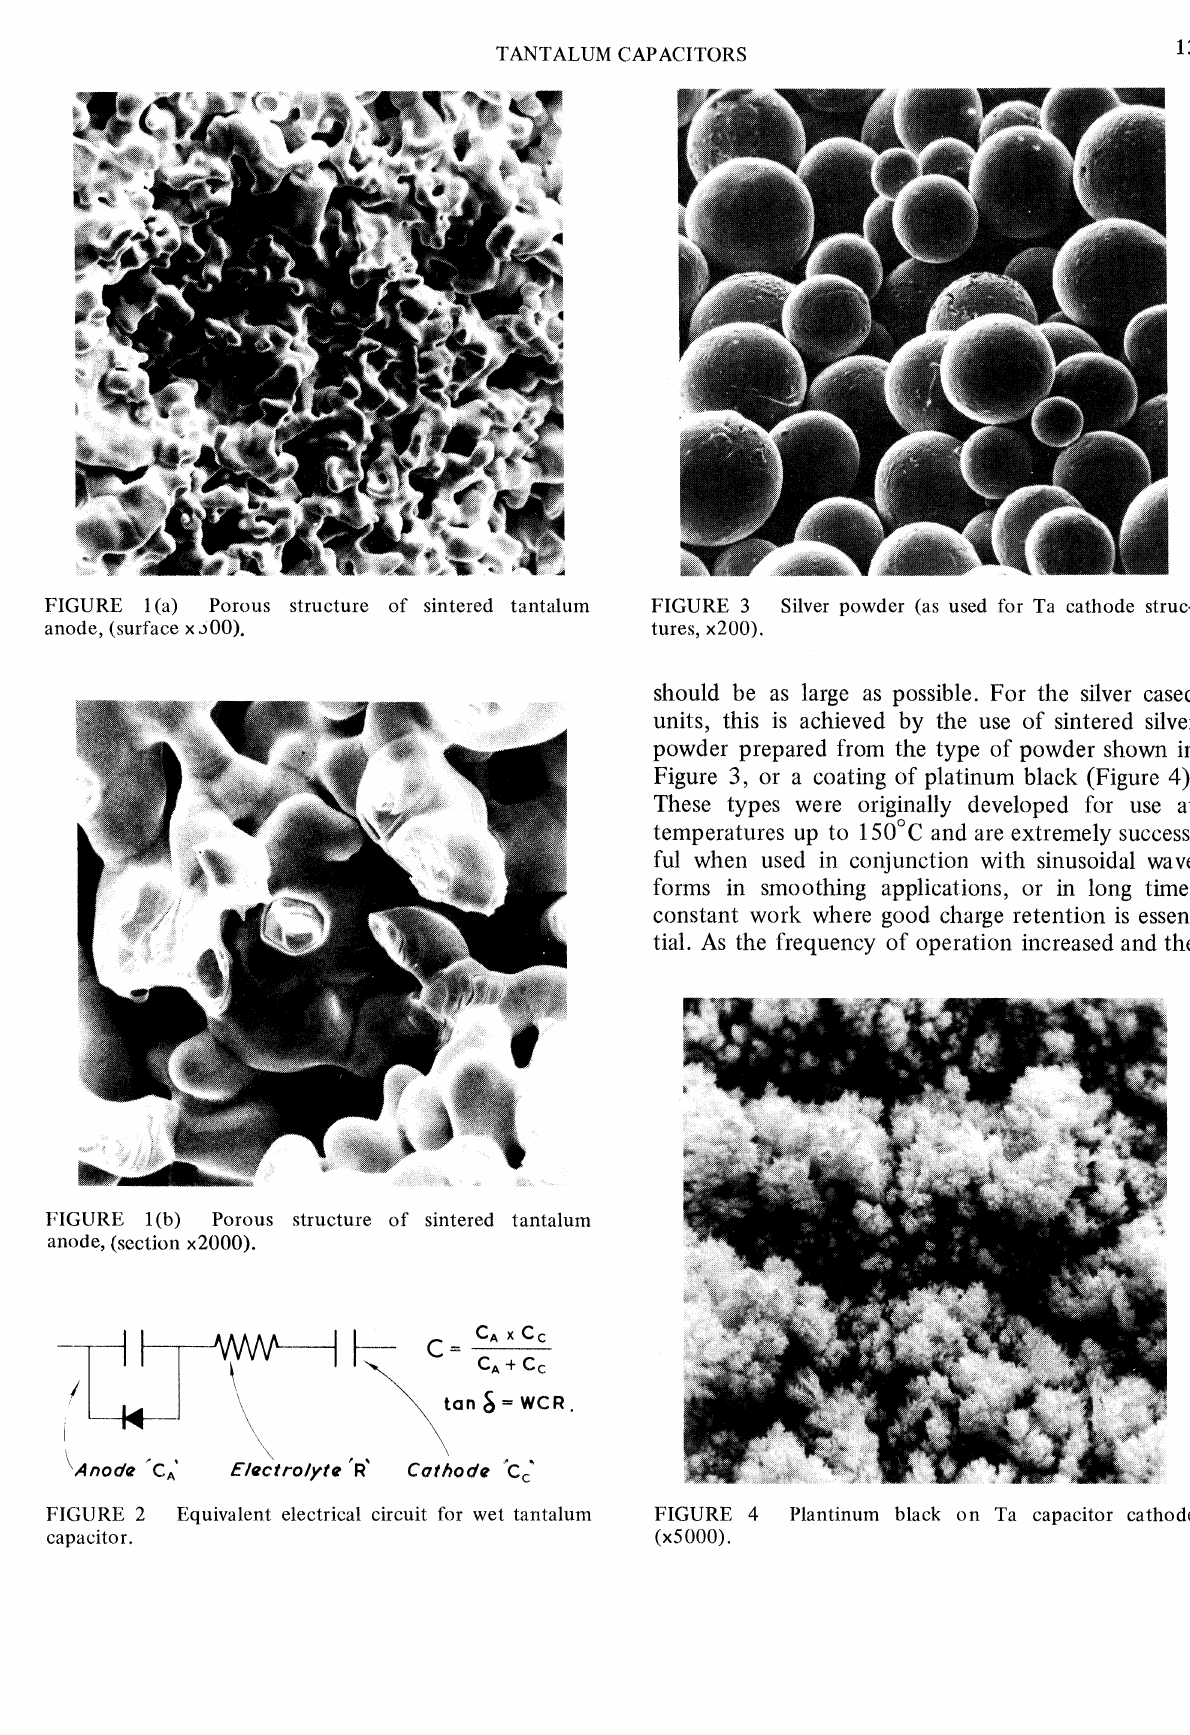
FIGURE 2 Equivalent electrical circuit for wet tantalum capacitor.